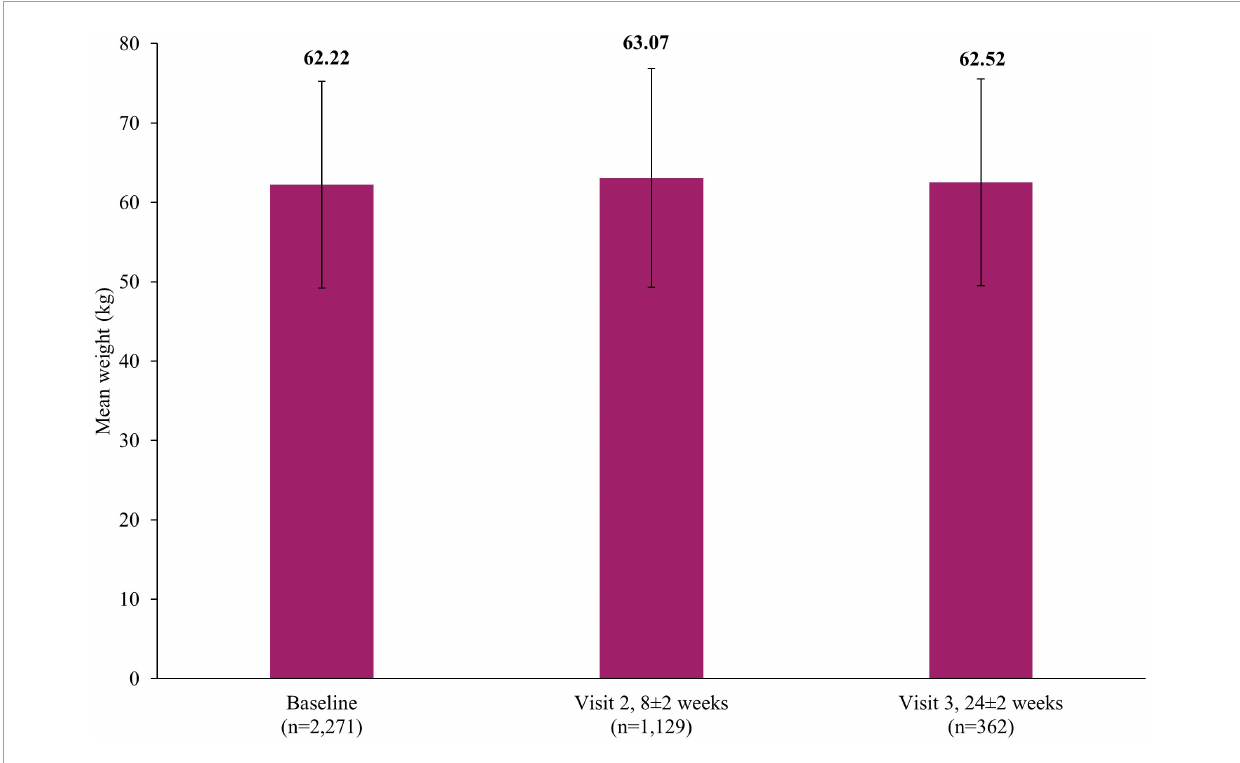
FIGURE2 Mean weight at baseline, Visit 2 and Visit 3. Error bars represent standard